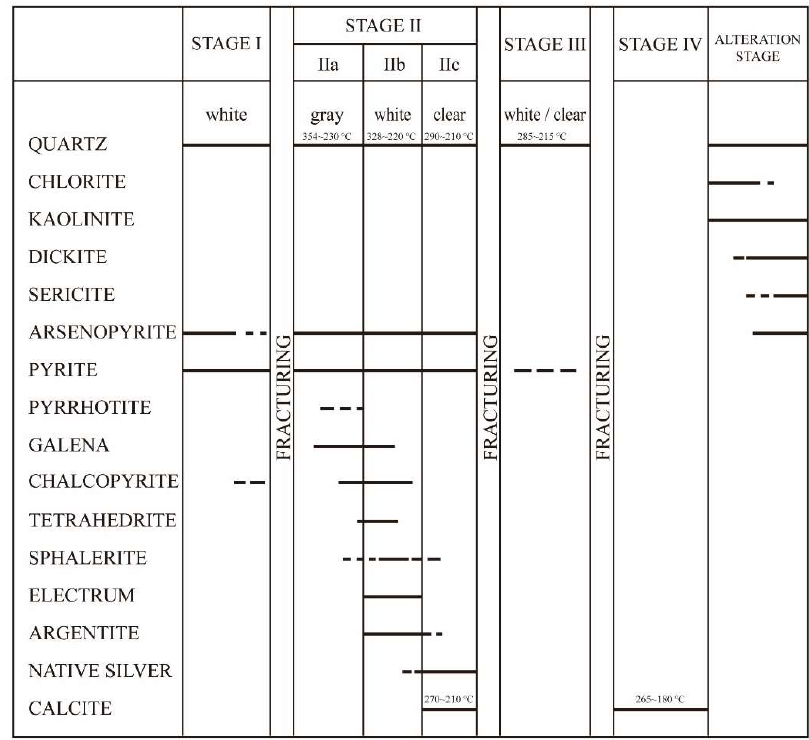
Figure 7. Vein mineralogical paragenesis of Eunjeok gold–silver deposit.